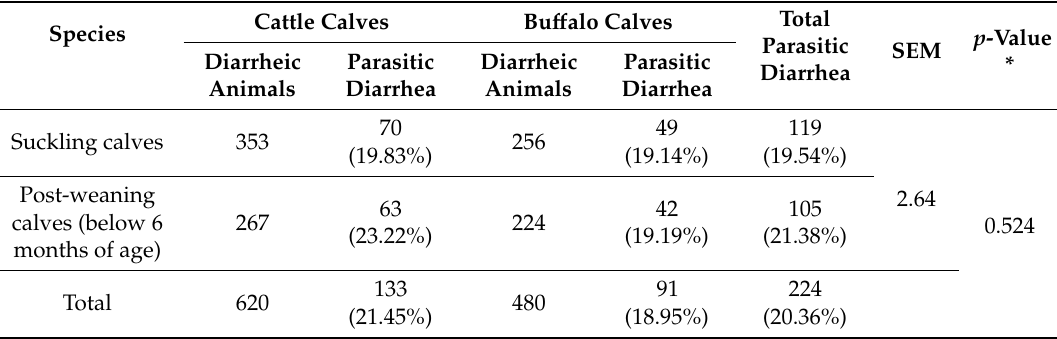
Table 1. Age-wise prevalence rate of parasitic diarrhea in cattle and bu ff alo